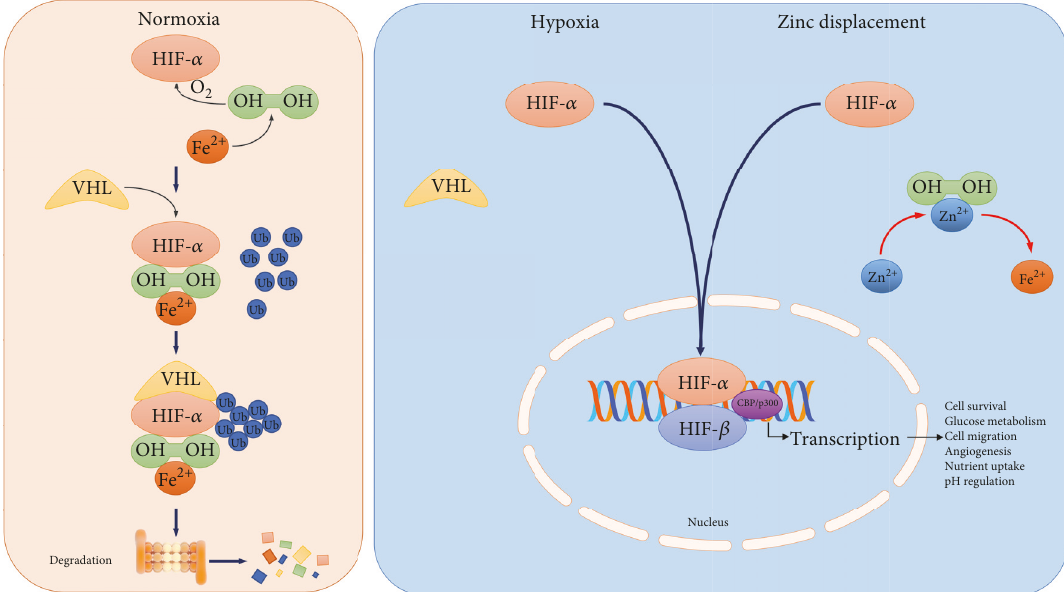
Figure 1: Control of cellular transcription by HIF- 𝛼 . Under normal oxygen tension, HIF- 𝛼 is hydroxylated (OH) through an iron (Fe 2+ ) dependent pathway to allow recognition by the von Hippel-Lindau (VHL) gene allowing ubiquitination (Ub) and proteosomal degradation. Hydroxylation cannot occur in hypoxia or displacement of iron by metals such as zinc (Zn 2+ ), allowing for HIF- 𝛼 to stabilize and bind with HIF- 𝛽 within the cell nucleus, resulting in the upregulation of cell survival